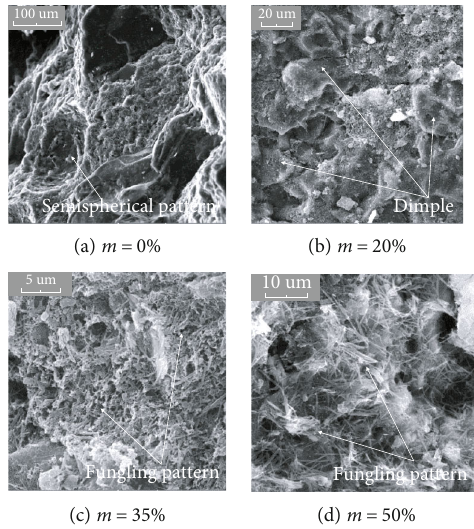
Figure 10: Fracture morphology of concrete mixed with fl y ash ( n = 120